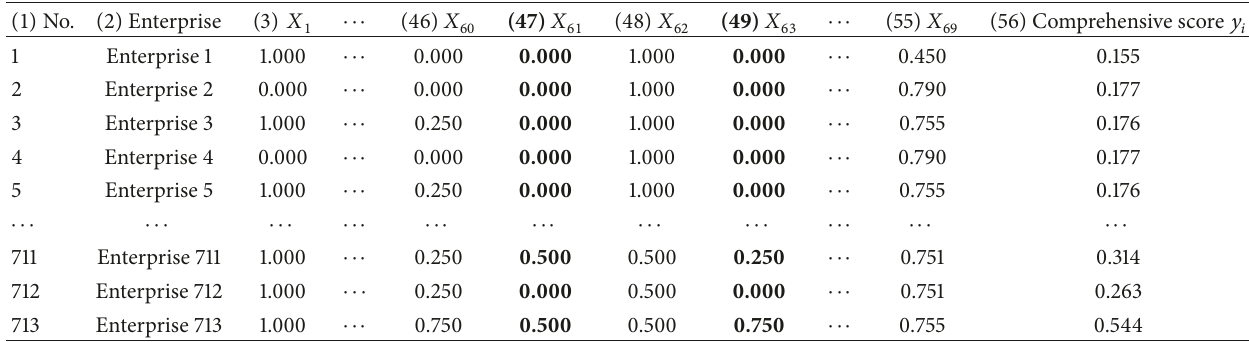
Table 4: 53 attributes and the comprehensive score 𝑦 𝑖 of 713 small